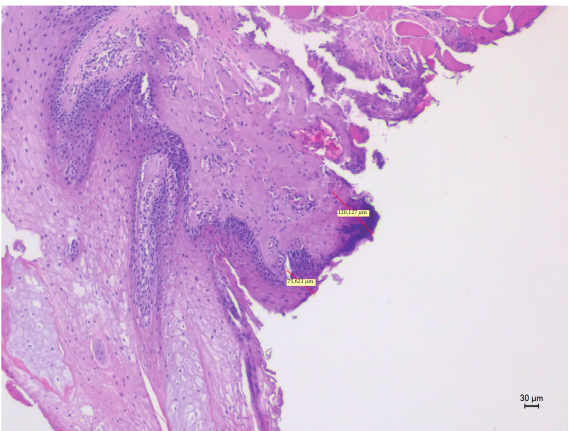
Figure 4: The histological specimen obtained using 5W in CW with colour EE at 10x magnification (group